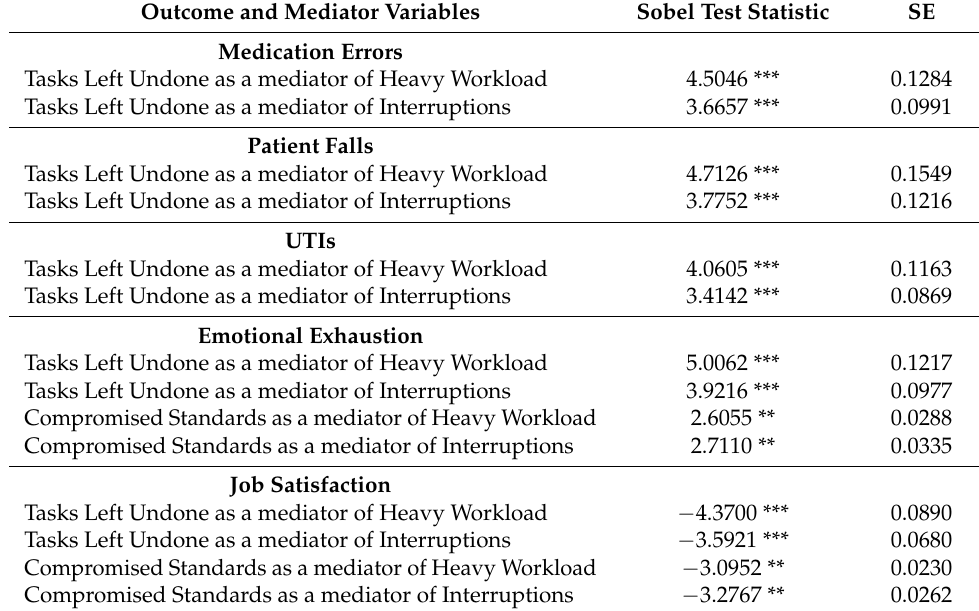
Table 7. Sobel test results for mediation